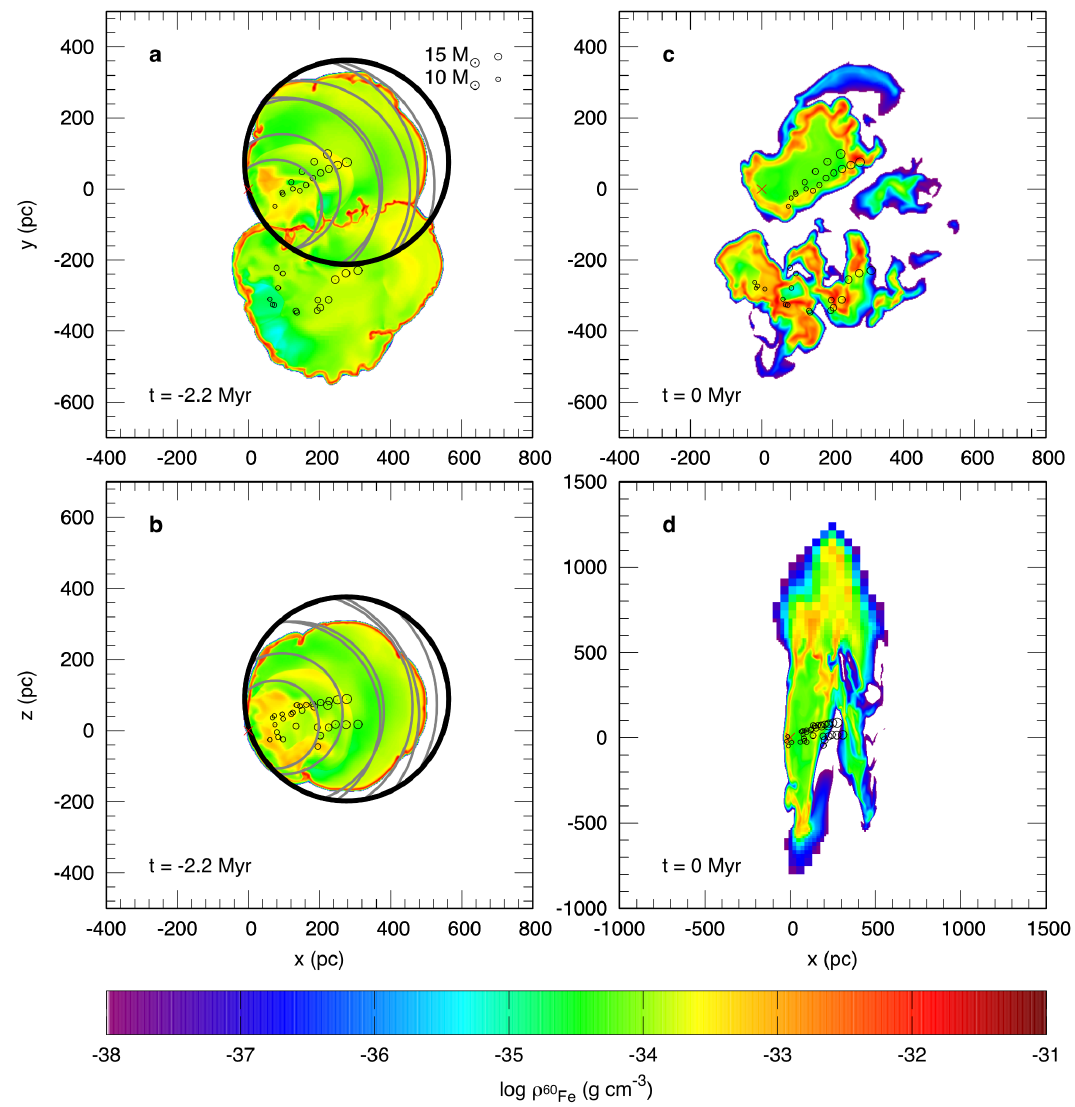
Figure 2. Color-coded maps of the logarithmic 60 Fe mass density distribution associated with the Local and Loop I superbubble, as derived from the numerical simulations with ( a , b ) homogeneous background medium (0.3cm − 3 number density, 6800K temperature, solar metallicity) at 2.2Myr before present and ( c , d ) inhomogeneous background medium as at present day. Vertical ( y = 0) and horizontal ( z = 0) cuts through the three-dimensional computational box are shown in the panels a , c and b , d , respectively. Earth’s projected position is at ( 0,0 ) and marked by a red cross. Thin black circles indicate the projected centers of the supernova explosions that occurred in the timeframe before the snapshot was taken. The sizes of the circles correspond to the initial masses of the progenitor stars (see legend in panel a ). Overplotted in the panels a and b are the results of the analytical calculations, with the Local Bubble’s outer shell depicted as a thick black circle, and the individual supernova blast waves in its interior as gray